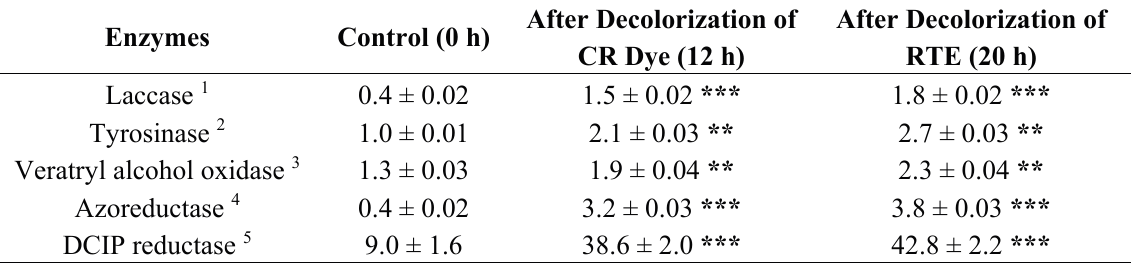
Table 3. Enzyme activities in microbial consortium control at 0 h (before addition of dye or textile effluent) and after CR dye (100 mg·L − 1 ) and RTE (50%) additions. After Decolorization of After Decolorization of Enzymes Control (0 h) CR Dye (12 h) RTE (20 h) Laccase 1 0.4 ± 0.02 1.5 ± 0.02 *** 1.8 ± 0.02 *** Tyrosinase 2 1.0 ± 0.01 2.1 ± 0.03 ** 2.7 ± 0.03 ** Veratryl alcohol oxidase 3 1.3 ± 0.03 1.9 ± 0.04 ** 2.3 ± 0.04 ** Azoreductase 4 0.4 ± 0.02 3.2 ± 0.03 *** 3.8 ± 0.03 *** DCIP reductase 5 9.0 ± 1.6 38.6 ± 2.0 *** 42.8 ± 2.2 *** Values are a mean of three experiments ±SE. Significantly different from control cells at ** p < 0.01 and *** p < 0.001 by one-way ANOVA with Tukey-Kramer comparison test. 1 µM of ABTS oxidized min − 1 ·mL of enzyme − 1 ·mg of protein − 1 ; 2 µM of catechol oxidized min − 1 ·mL of enzyme − 1 ·mg of protein − 1 ; 3 µM of veratryl alcohol oxidized min − 1 ·mL of enzyme − 1 ·mg of protein − 1 ; 4 μ M of Methyl red reduced min − 1 ·mL of enzyme − 1 ·mg of protein − 1 ; 5 μ M of DCIP reduced min − 1 ·mL of enzyme − 1 ·mg of protein − 1